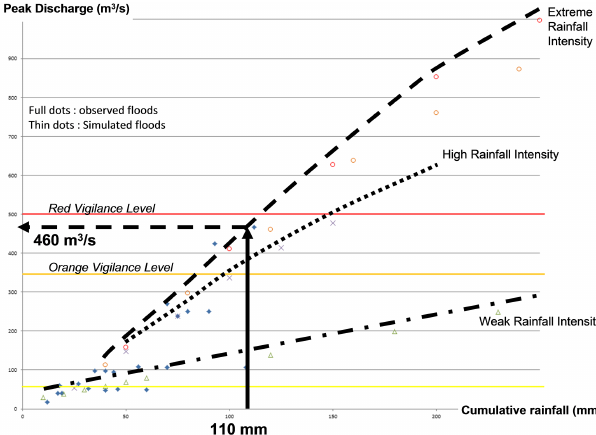
Figure 4. Graphical tool of the peak discharge in response to rain- falls (intensity and amount) (Borrell Estupina et al., 2014). For ex- ample, in September 2005, the next 110mm of rainfall during the next 3h contributed to the surface flood. The average rainfall in- tensity of 37mmh − 1 was high enough to be considered as extreme. The peak discharge estimated by the graphical tool was 460m 3 s − 1 , to be compared to the measured 467m 3 s − 1